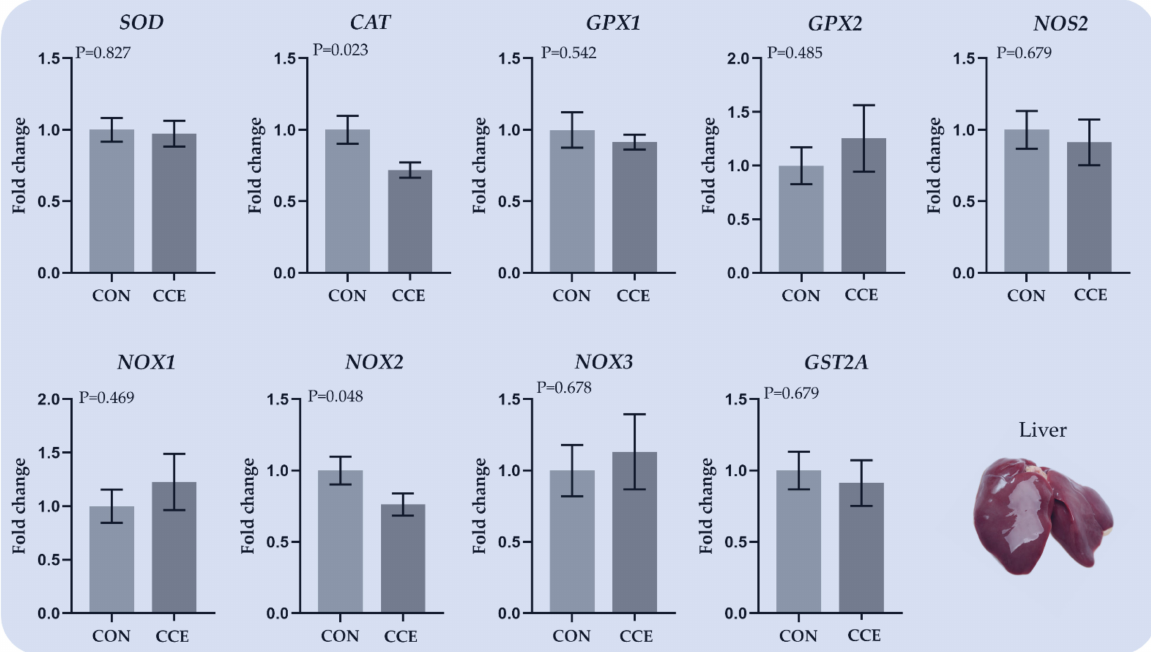
Figure 4. The mean and standard error of means (SEM) of relative transcript levels as fold changes of several genes involved in the antioxidant system in the liver of broilers fed the two experimental diets (Control; CON and carotenoid extract from Citrus reticulata included in soluble starch; CCE) at 42 days. SOD: Superoxide Dismutase, CAT: Catalase, GPX1: Glutathione Peroxidase 1, GPX2: Glutathione Peroxidase 2, NOS2: Nitic Oxide Synthase 2, NOX1: NADPH oxidase 1, NOX2: NADPH oxidase 2, NOX3: NADPH oxidase 3, and GSTA2: Glutathione Transferase A2